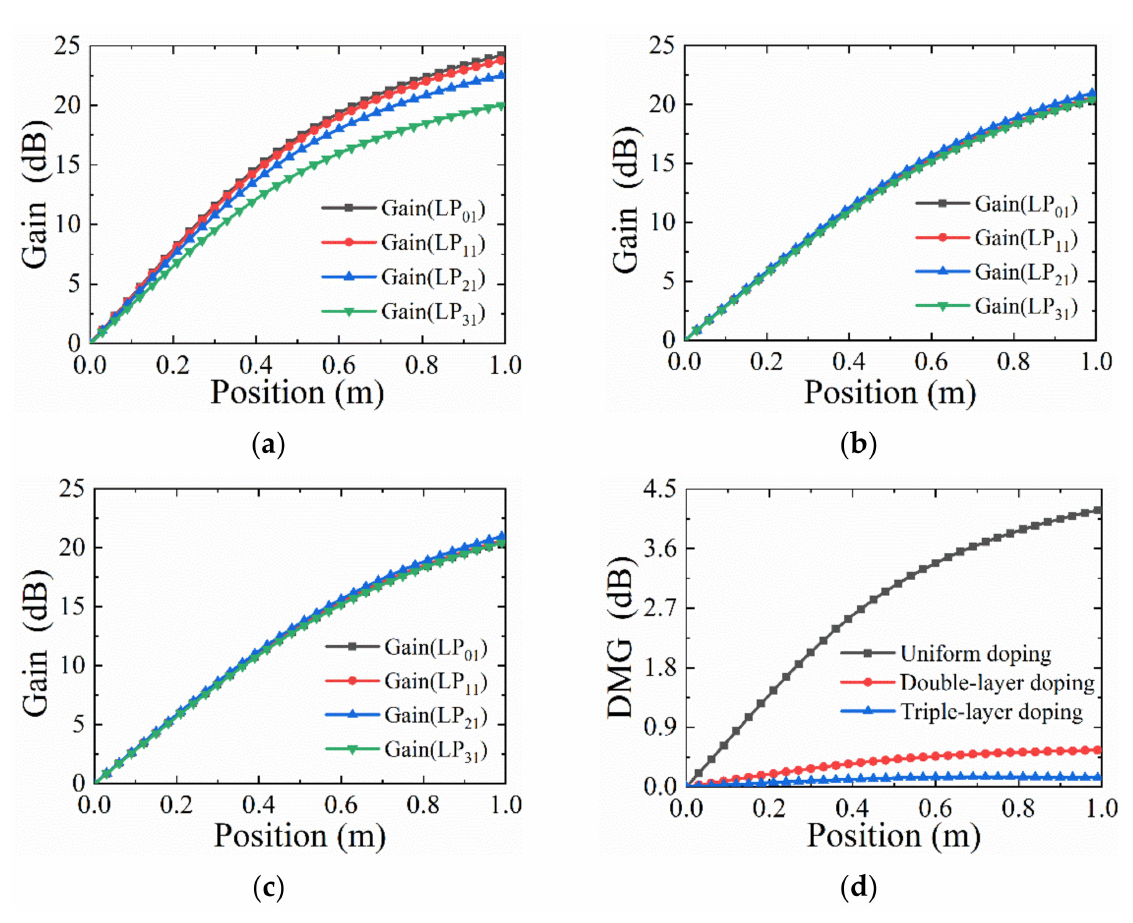
Figure 3. Gain characteristics under ( a ) uniform-, ( b ) double-layer, and ( c ) triple-layer doping design. ( d ) DMG versus fiber length.